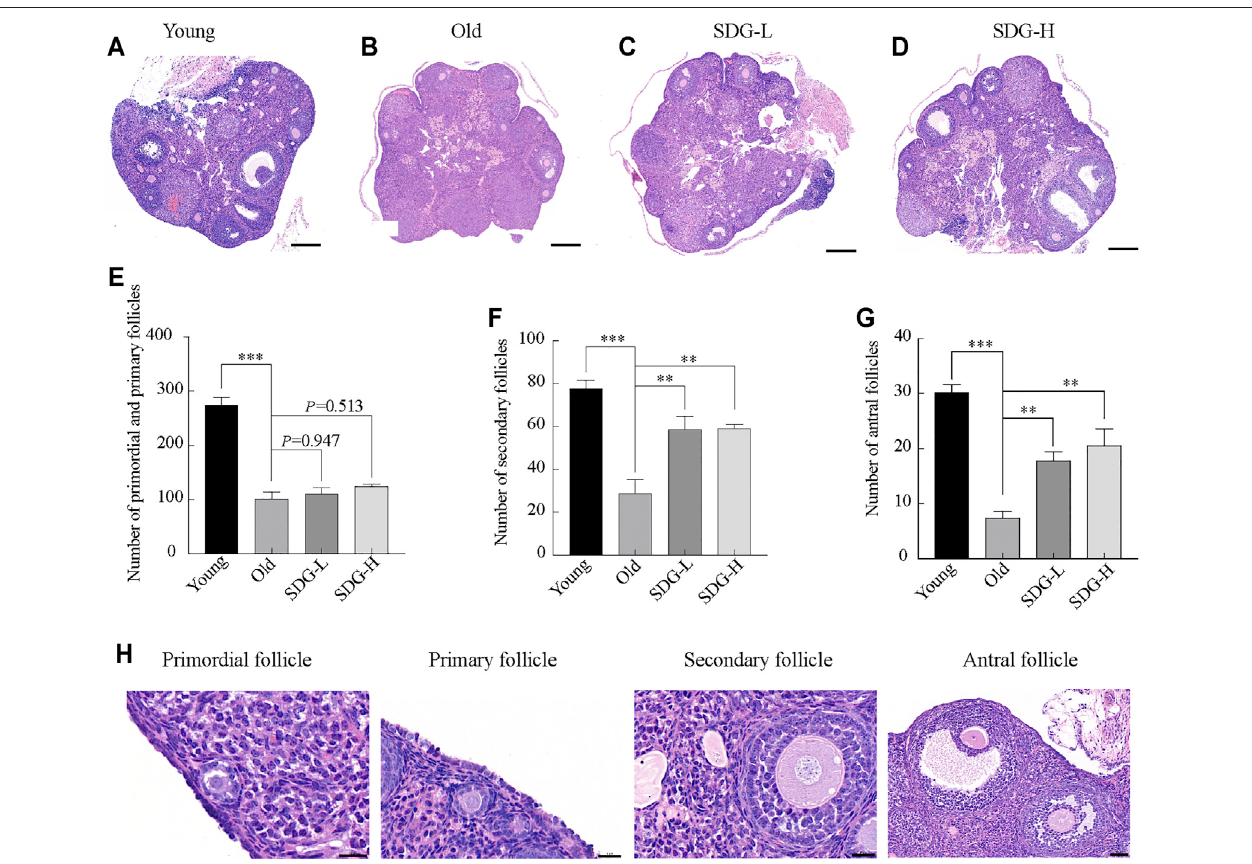
FIGURE 2 | Ovary morphology and follicle counting in mice after intragastric administration of SDG. (A – D) Morphology of ovaries from each group of mice. Scale bar, 200 µm. Representative samples from Young (A) and the Old (B) mice treated with saline, SDG-L (C) and SDG-H (D) with a concentration of 7 and 70 mg/kg daily for8 weeks (E – G) Thenumberofprimordialandprimary (E) ,secondary (F) ,andantral (G) follicles.Theserialsectionsfromeachovarywerestainedwithhematoxylinand eosin. The total number of follicles per whole ovary was calculated by combining the counts. The morphology of different types of follicles are shown in (H) . Primordial and primary follicles, scale bar, 20 μ m; secondary follicles, scale bar, 20 μ m; antral follicles, scale bar, 50 µm. The data are expressed as mean ± SEM. * P < 0.05, ** P < 0.01, *** P < 0.001. The P value is labeled if P >